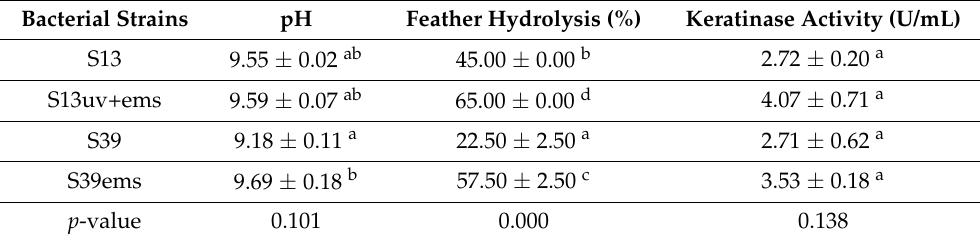
Table 1. Evaluation of feather degrading ability of S13uv+ems and S39ems and their wild type for SEM